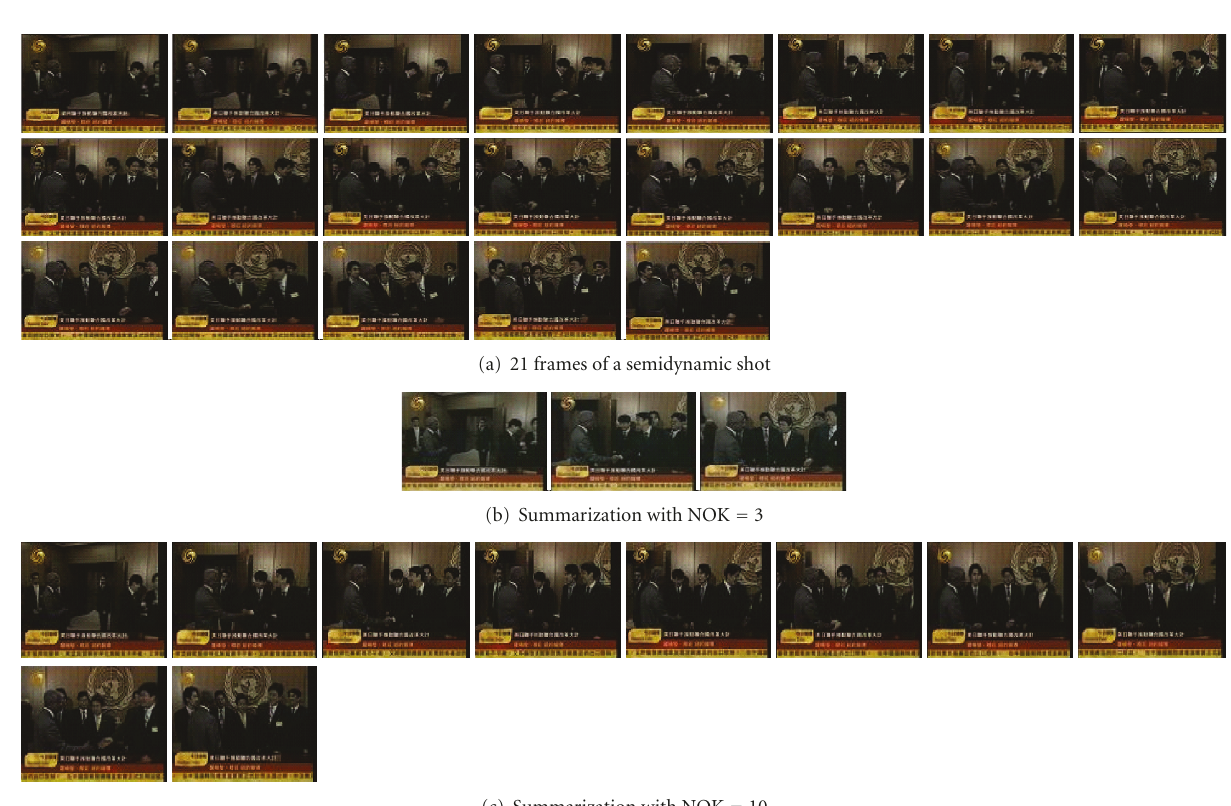
Figure 4: Some of the frames of a semidynamic shot which has been summarized with 3 and 10